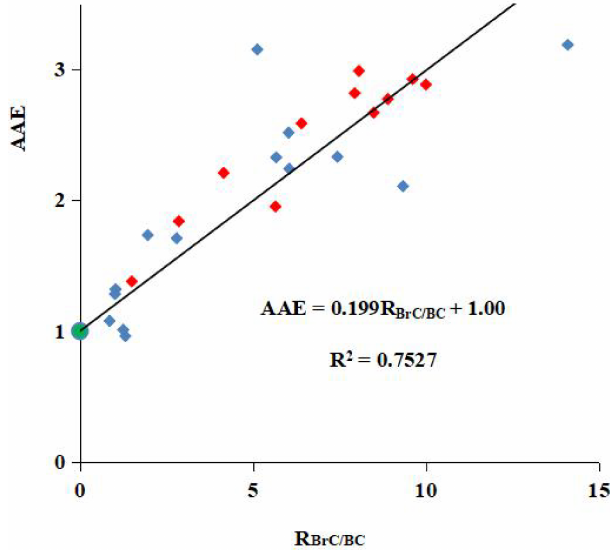
Figure 2. Relationship between AAE and the EF BrC / EF BC ratio ( R BrC / BC ) for both biomass fuel (red) and coal (blue). The intercept is designated as 1.0 to echo the conventionally accepted notion that the AAE for pure BC (i.e., R BrC / BC = 0) is